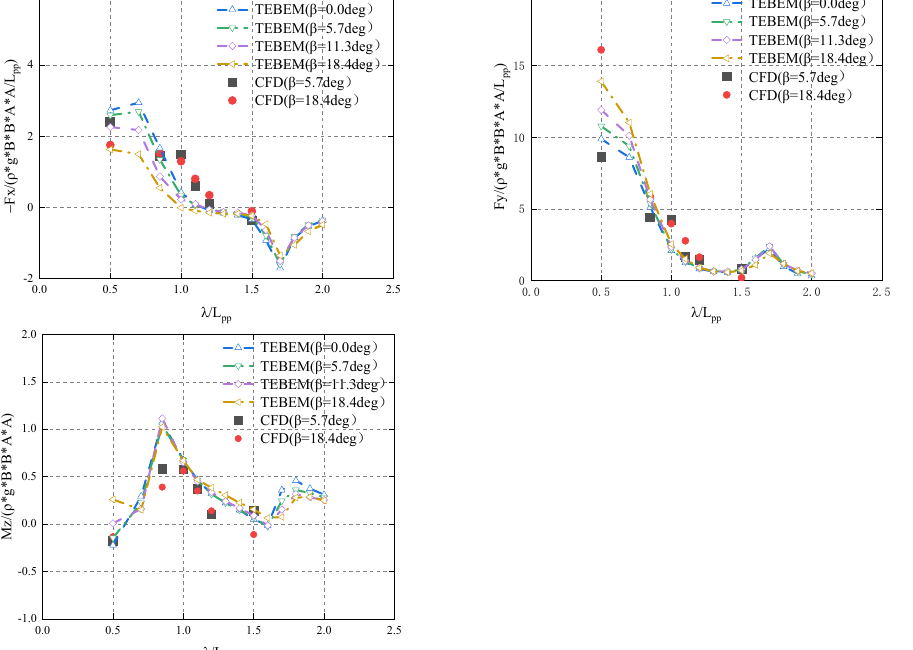
Figure 17. The surge, sway, and yaw wave drift forces and moment of KVLCC2 with H = 0.02 L PP , χ = 120°, β = 0°, 5.7°, 11.3°, 8.4°, and U = 6.0 kn. The wave drift forces and moment of the ship with drift angle at different wave incident angles are also calculated. Figure 18a–c depict the surge, sway, and yaw wave drift forces and moment of the KVLCC2 with H = 0.02 L PP , χ = 0°, 30°, 60°, 90°, 120°, 150°, 180°, β = 18.4°, and U = 6.0 kn, respectively. The surge wave drift force increases with the increase in wave direction angle in bow waves in Figure 18a for λ/L PP ≤ 1.0. The sway wave